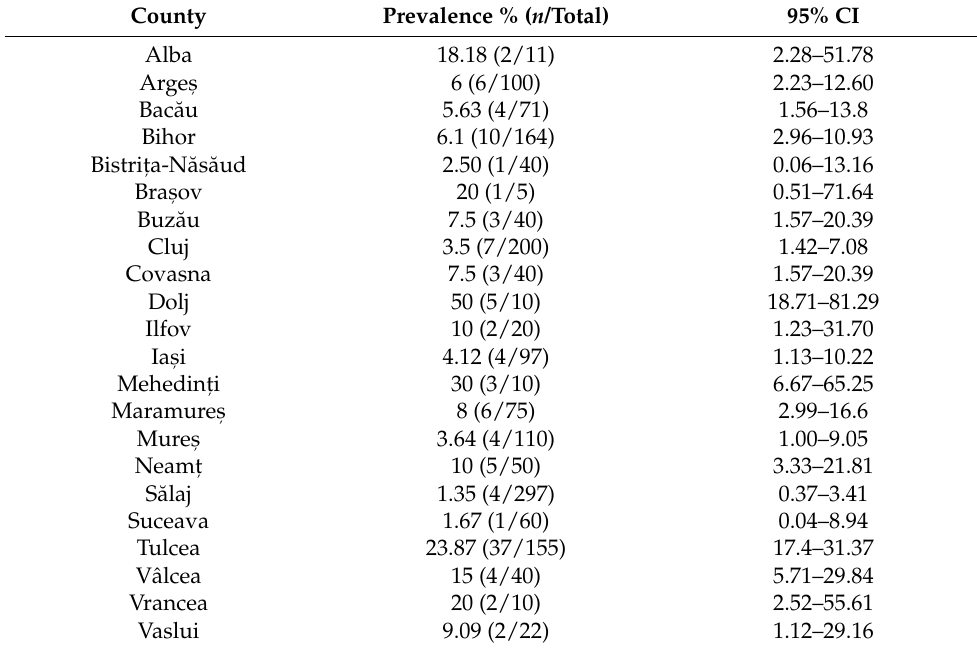
Table 4. Rickettsia spp. prevalence in Romanian